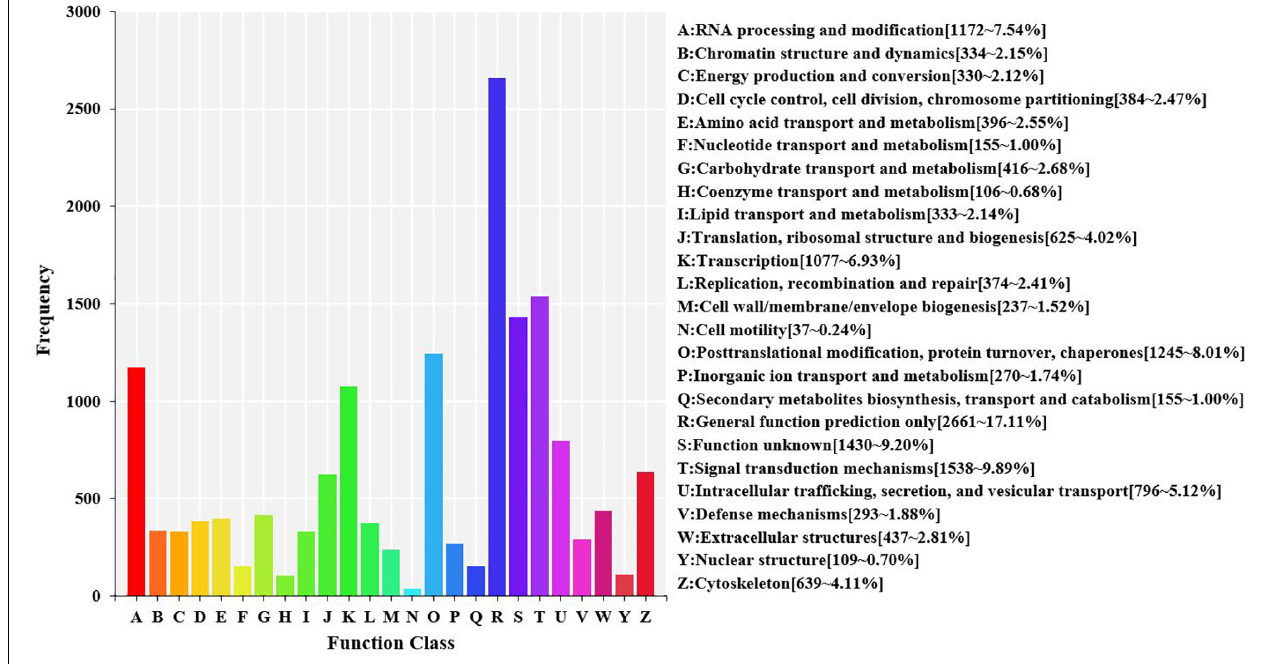
FIGURE 5 | Eukaryotic orthologous groups ( KOG) function classification in the transcriptome of hemocytes in Marsupenaeus japonicus hemocytes. Each bar represents the number of unigenes classified into each of the 25 KOG functional categories. The X -axis stands for the functional categories, and the Y -axis indicates the